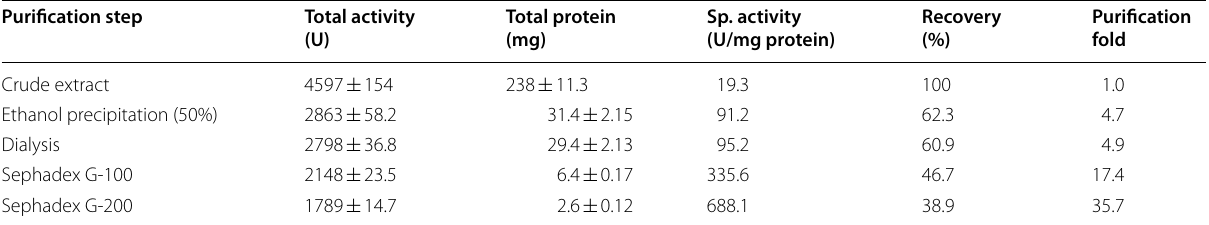
Data is expressed as mean